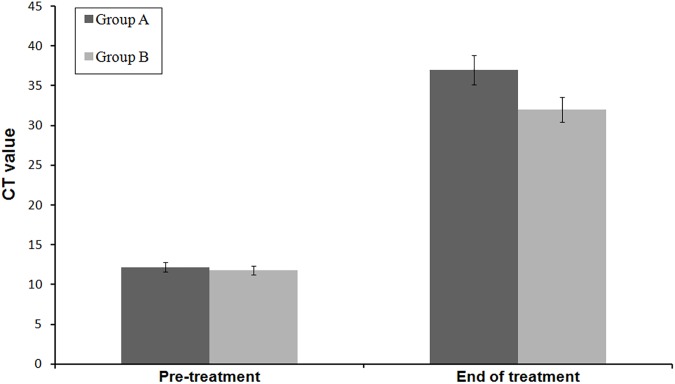
Parasitic load before treatment and at end of treatment shown by bar graph in which parasitic load is inversely proportional to Ct value.